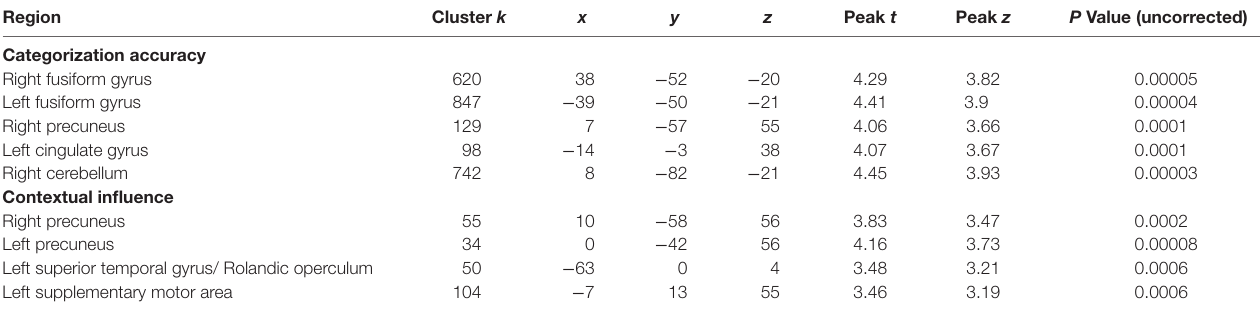
Right precuneus